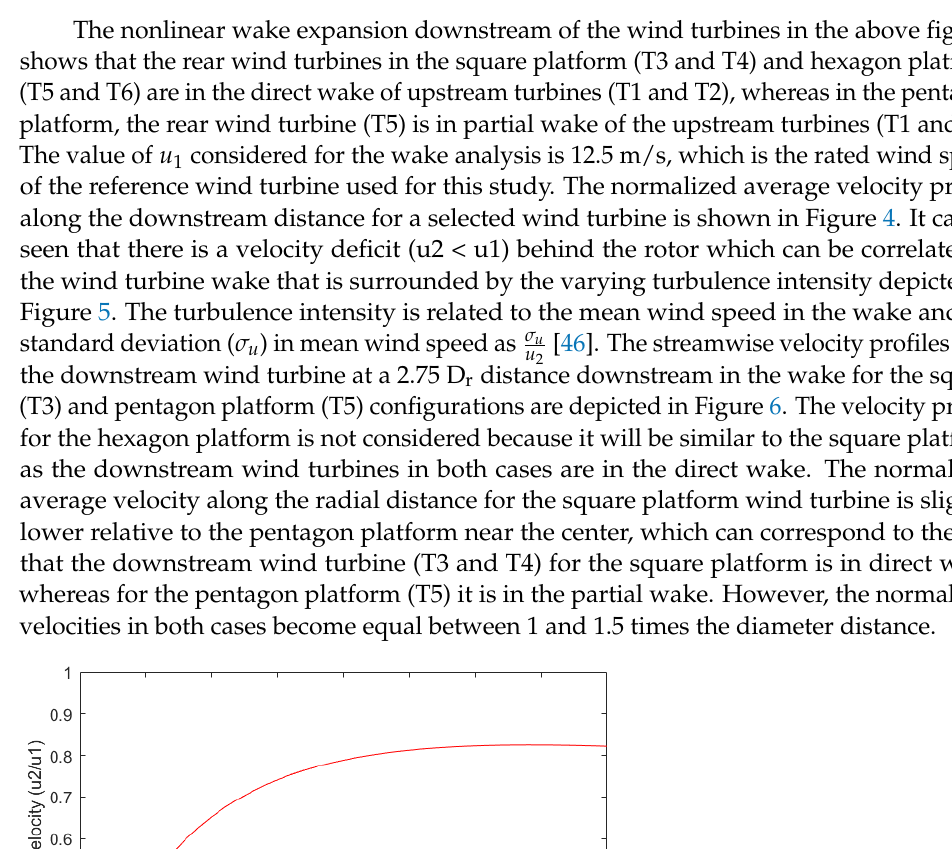
Figure 6. Velocity profile of the downstream turbine. In this study, the rotors of the configurations are modeled using an actuator disk technique [44]. The rectangular computational domain of dimensions 20D(X) × 15D(Y) is created in the ANSYS design modeler. The discretization of the model is performed using quadrilateral elements by employing refinement at the rotors. The wall boundary condi- tion is imposed on the top and bottom boundaries of the computational domain. The three grid refinement levels used for generating the number of elements for the square config- uration, pentagon configuration, and hexagon configuration are presented in Table 2. Dif- ferent numbers of quadrangular layers and growth rates were used to develop the three meshes. An inflation tool with a growth rate of 1.2, 1.1, and 1.05 was used to obtain various levels of quadrangular cells in the boundary layer of the rotor disk so that y + is less than 1, as necessary by turbulence models [43,47,48]. To obtain the grid-independent results, different levels of grid refinements were tested in ANSYS Fluent to reach y + < 1 for all the conditions of the rotor. Figure 7 presents the mesh sensitivity study results in terms of a normalized velocity profile for turbine 5 of the pentagon platform configuration. This sen- sitivity study showed that mesh 2 and mesh 3 have approximately similar results and